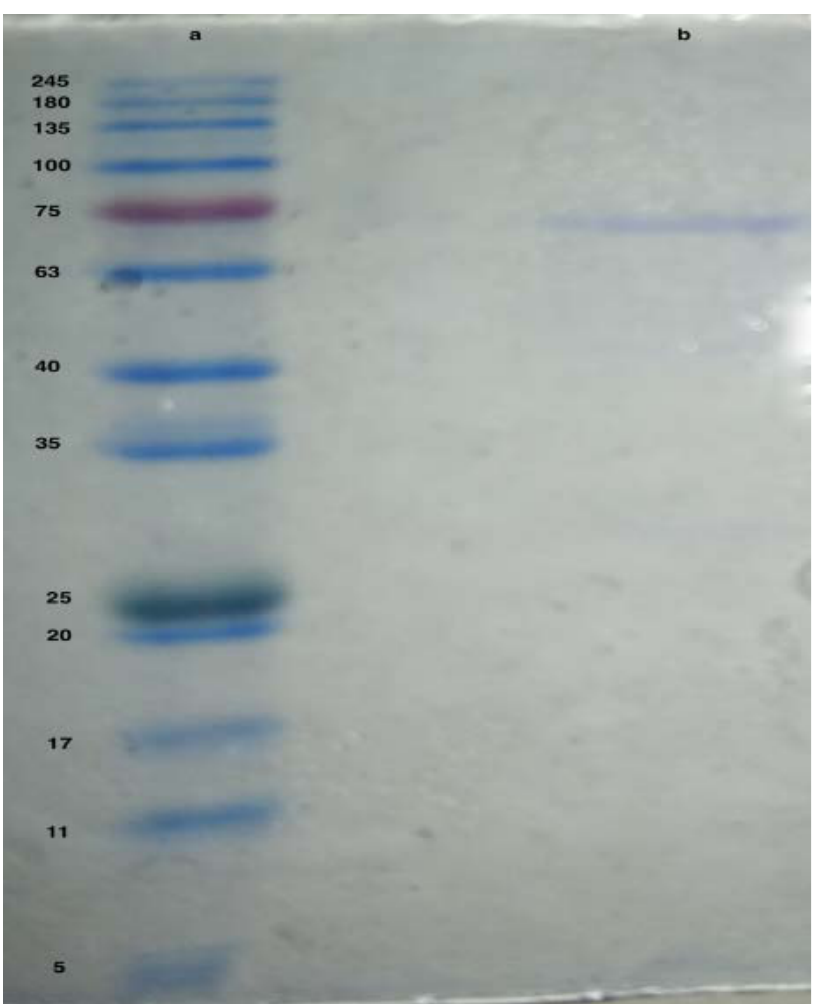
Figure 2. Purified asparaginase from L. theobromae on SDS-PAGE. ( a ) protein ladder, ( b ) purified asparaginase.